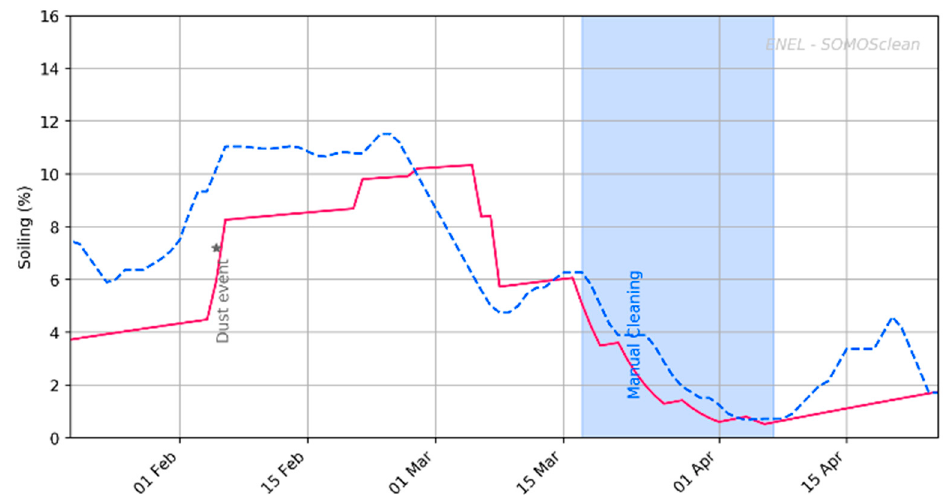
Figure 4. Gradual degrees of soiling during manual cleaning in a large PV plant. Soiling model is represented in magenta, and the soiling calculated from performance at midday in dashed blue line.